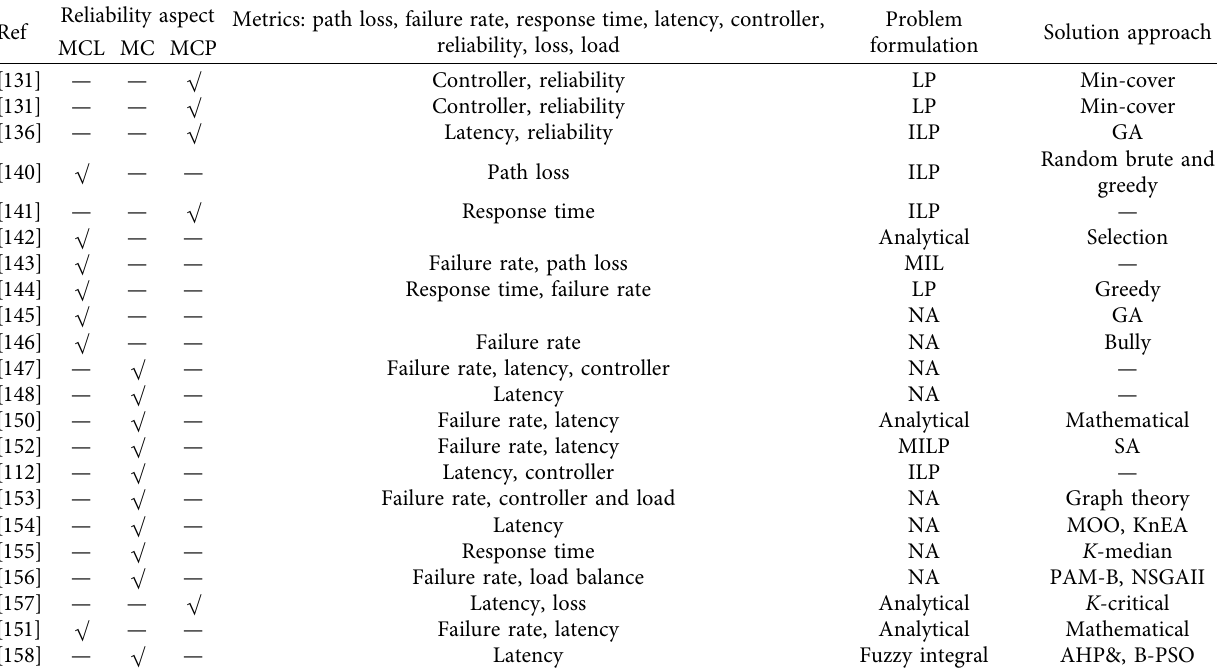
Table 7: Comparison of resilience aware controller placement.